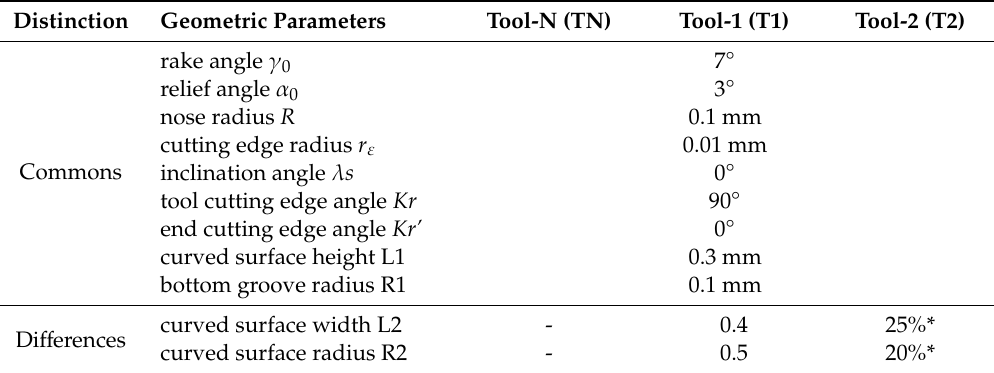
Table 1. Geometry of the